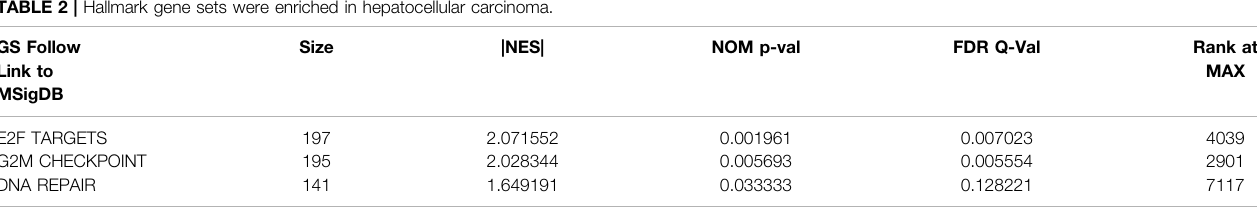
TABLE 2 | Hallmark gene sets were enriched in hepatocellular carcinoma.